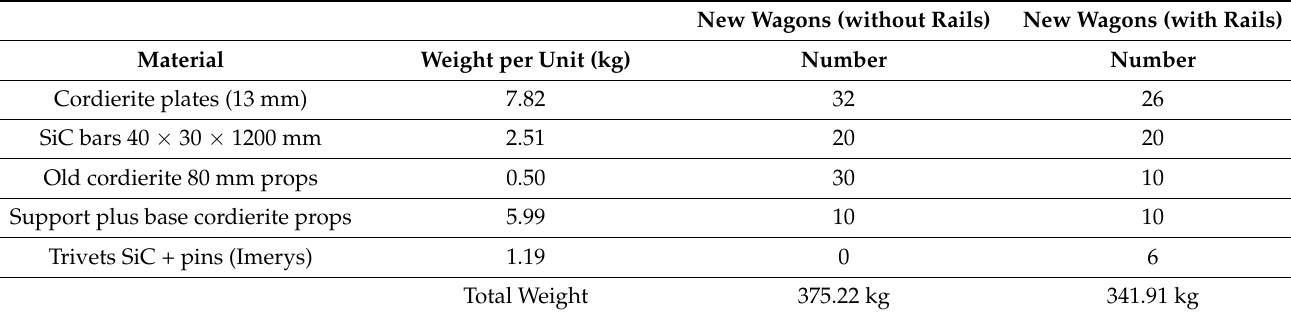
Table 9. Constitution of current wagons and their respective